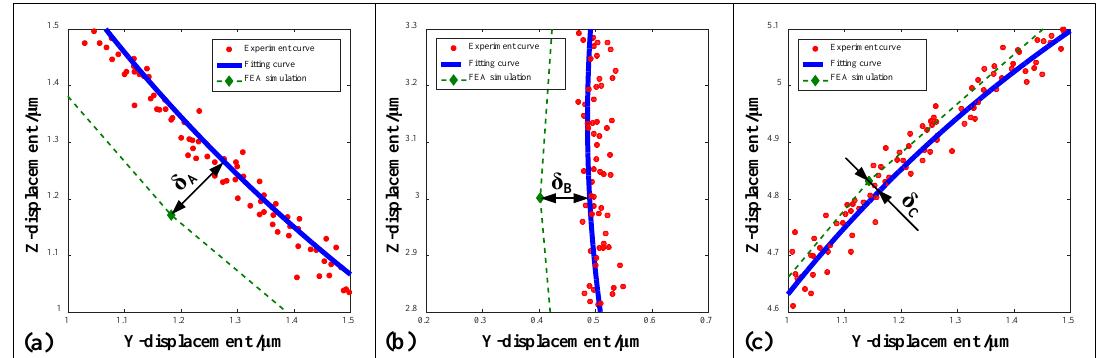
Figure 12. Comparative analysis of the tracking precisions of local elliptical trajectories generated by the 2-DOF PDCM. ( a ) Region A, δ A = 0.1331 μm; ( b ) Region B, δ B = 0.0873 μm; ( c ) Region C, δ C = 0.0256 μm.